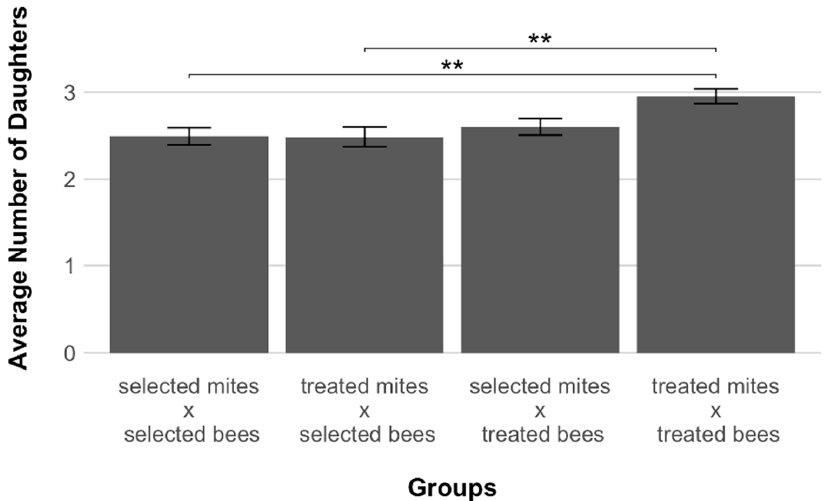
Figure 3. Average number of daughters ( ± SE) produced by female mites, Varroa destructor , in experimentally infested honey bee, Apis mellifera , worker brood cells of the different host groups (selected-selected, treated-selected, selected-treated, treated-treated). After Bonferroni adjustment, significant differences were detected between groups (** = p < 0.01). Both selected and treated mites infesting selected bees produced significantly less daughters than treated-associated mites infesting their original